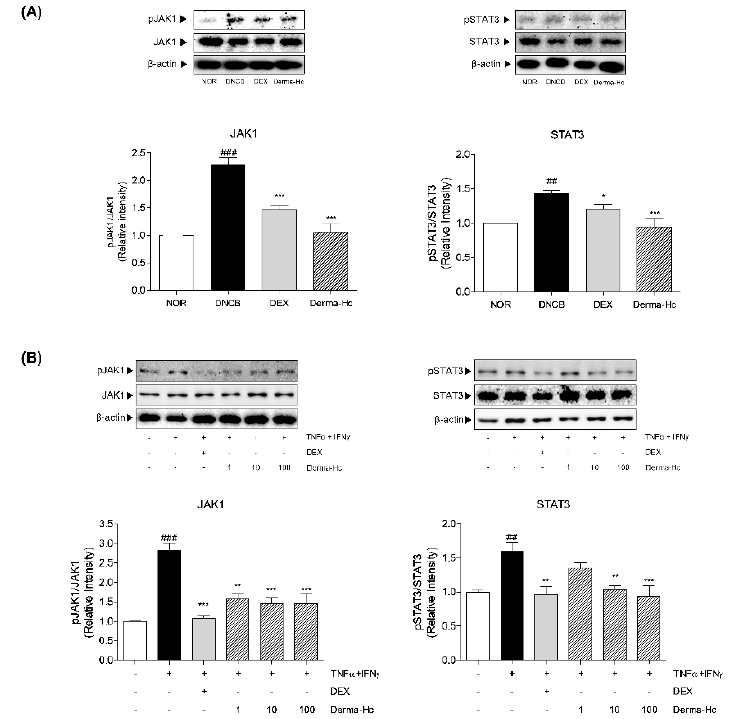
Figure 8. Derma-Hc decreases the expression levels of janus kinase 1 (JAK1)-signal transducer and activator of transcription 3 (STAT3) signal pathway in ( A ) DNCB-induced mice and ( B ) TNF- α +IFN- γ -treated human keratinocytes. The protein levels of phosphorylated janus kinase 1 (pJAK1) and phosphorylated signal transducer and activator of transcription 3 (pSTAT3) were analyzed by western blot assay. Three repeats of an experiment were conducted. The data are presented as mean ± standard error of the mean. ## p < 0.01 and ### p < 0.001 compared to NOR group. * p < 0.05, ** p < 0.01 and *** p < 0.001 compared to individual groups.